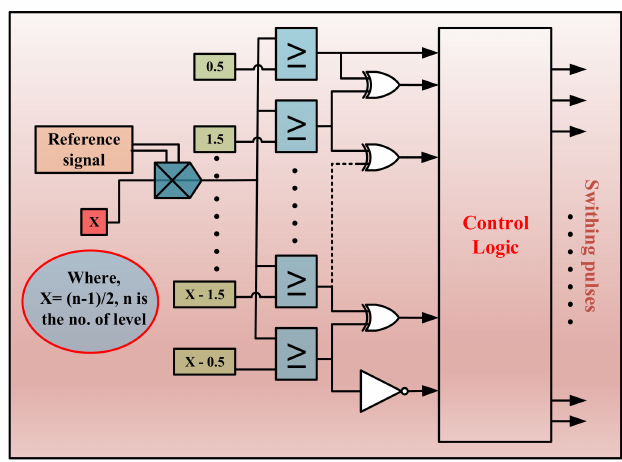
Figure 5. Simplified